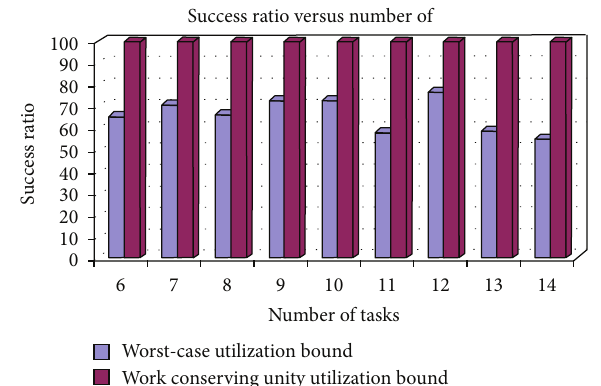
Figure 11: Comparison of Effective processor utilization of the algorithms